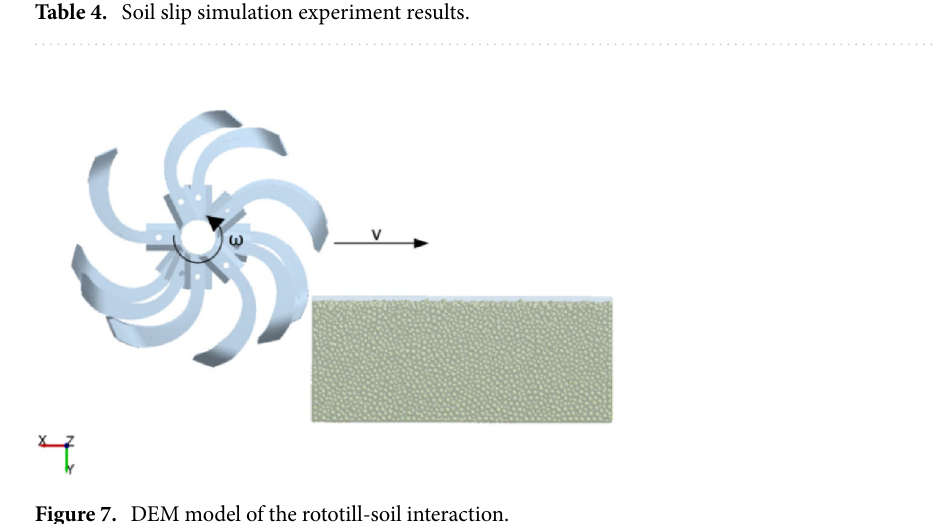
Figure 7. DEM model of the rototill-soil interaction.